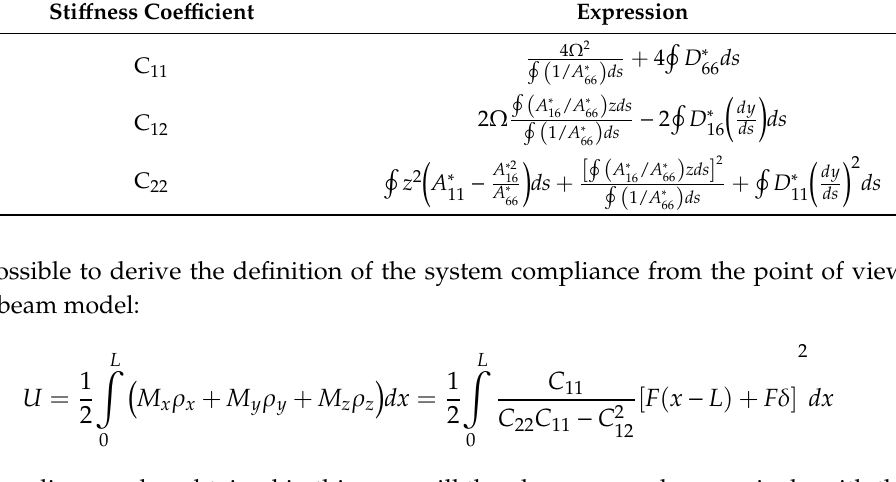
Table 1. [ C ] Matrix sti ff ness coe ffi cients for CAS configuration in coupled planar bending-torsion. Sti ff ness Coe ffi